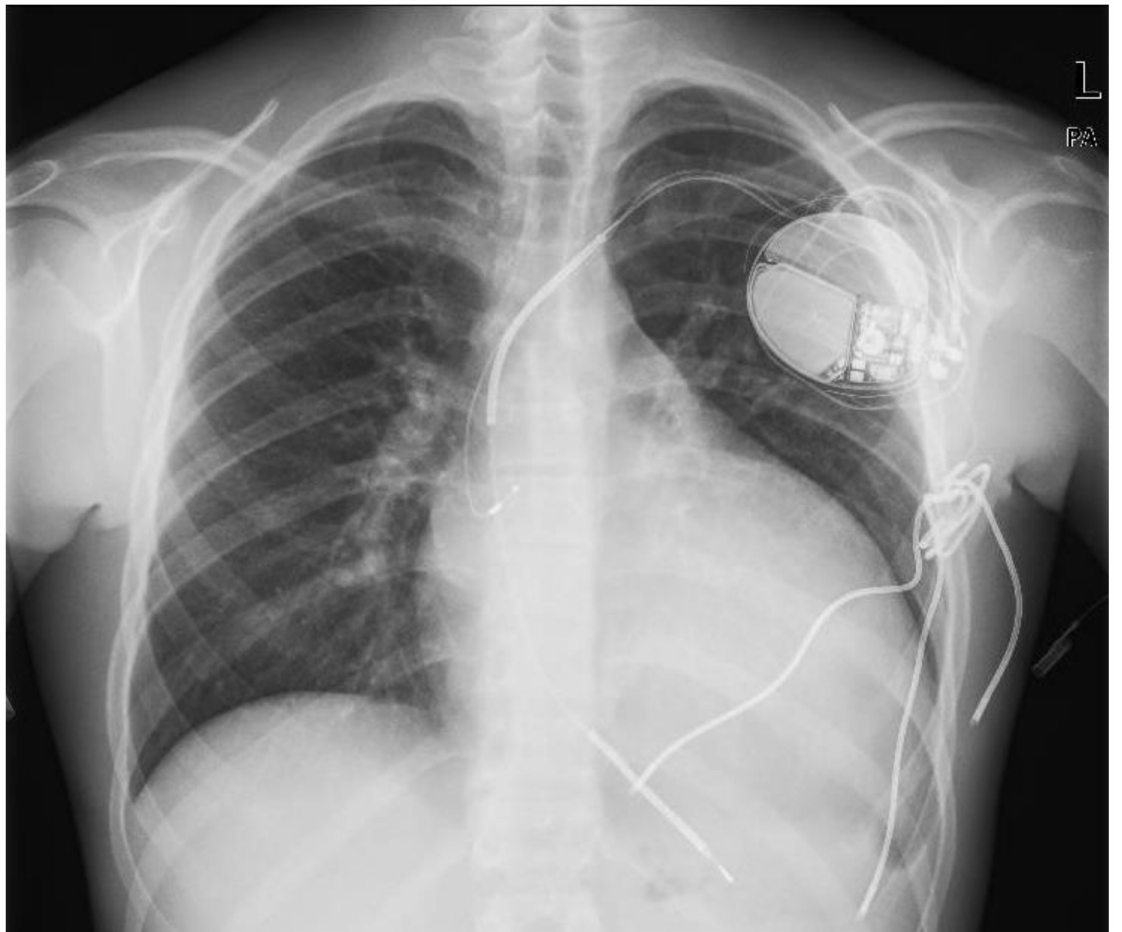
Figure 1. Anterior–posterior (AP) chest X ray showing dual-chamber ICD with a dual-coil defibrillation ventricular lead and subcutaneous multi-coli arrays tunneled into the left postero-lateral position and connected to the SVC port of